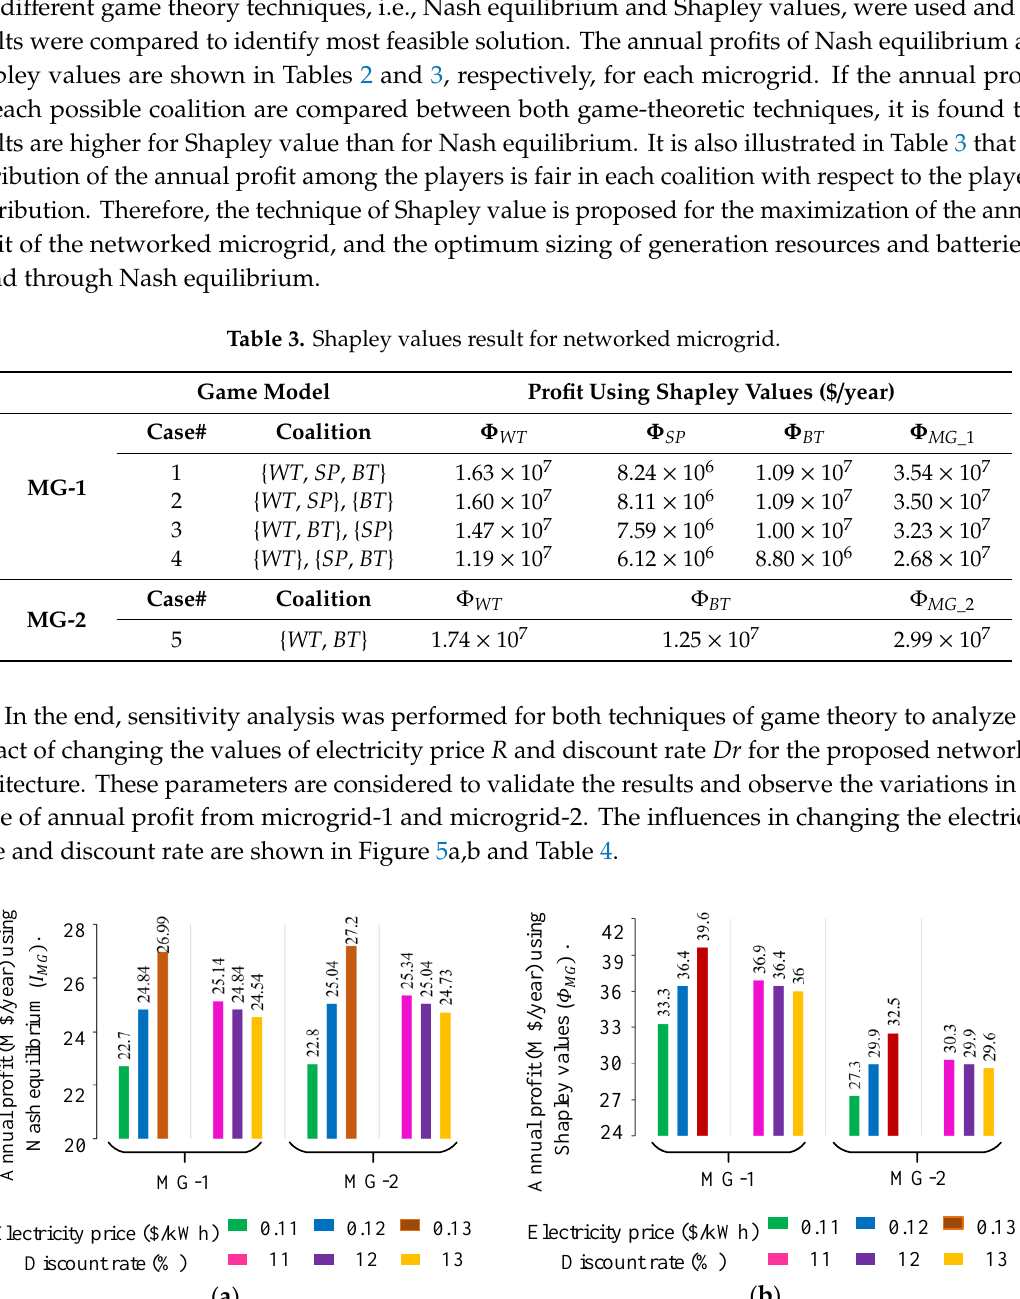
Table 3. Shapley values result for networked microgrid.